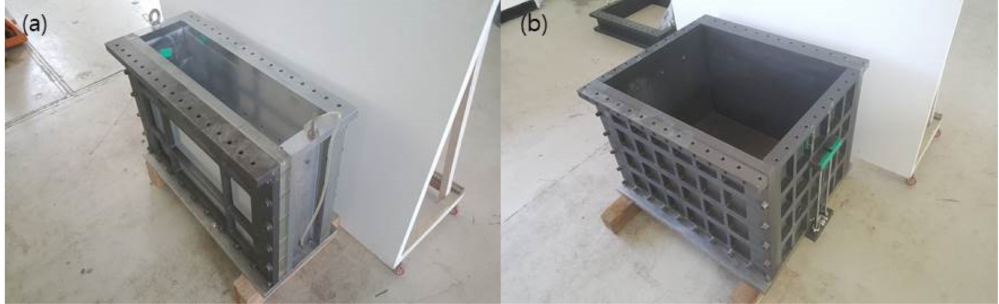
Figure 1. ( a ) Static lateral loading test used soil box. ( b ) Cyclic lateral loading test used soil